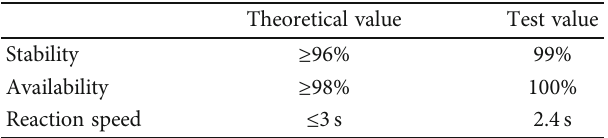
Table 2: Test results of physical training teaching platform